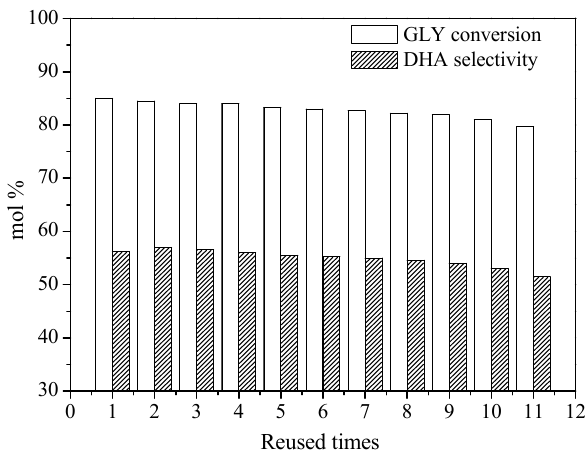
Figure 7. Reusability of LDH ‐ [Cr(SO 3 ‐ salphen)]. Reaction conditions: GLY (25 mL 0.4 mol L − 1 aqueous solution), 3% H 2 O 2 (30 mL), catalyst (0.2 g), 60 °C, 6 h.